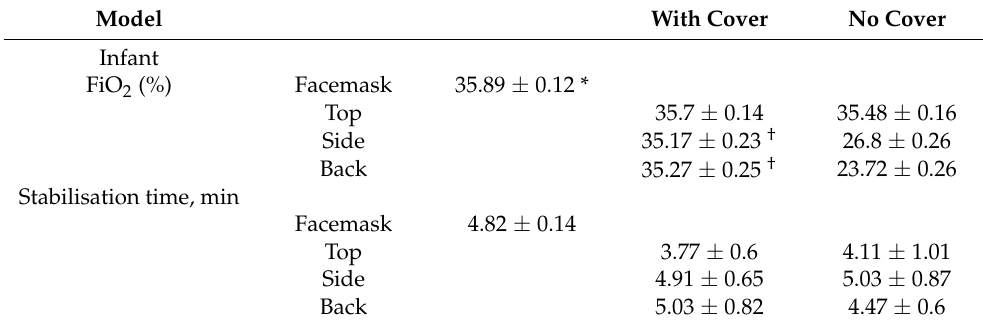
Table 2. FiO 2 and stabilisation time between mask and hood delivery systems in infant and pediatric